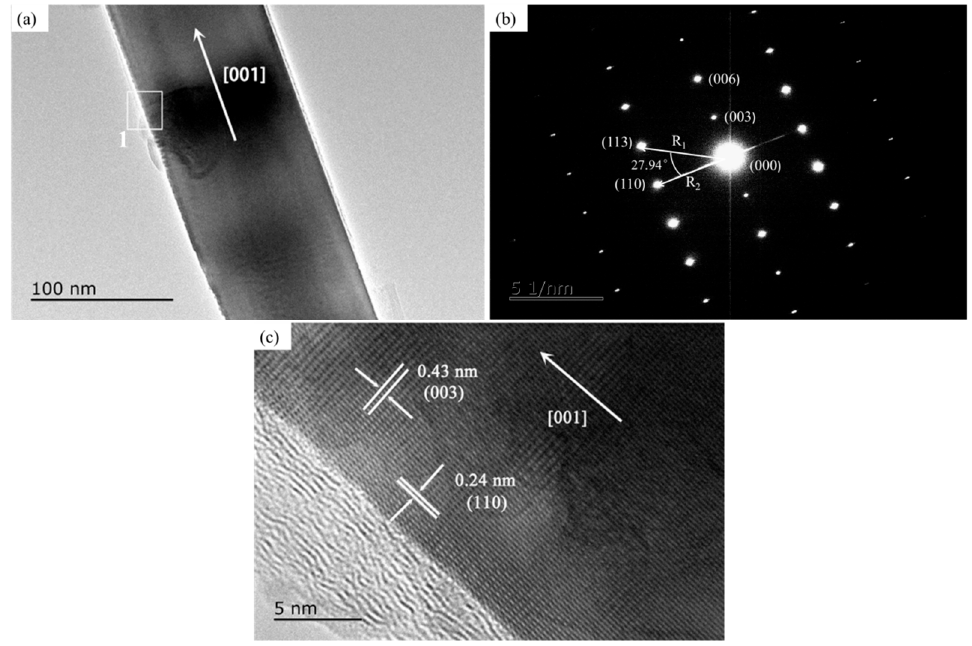
Figure 6. TEM image of Al 2 O 3 whisker: ( a ) general TEM image; ( b ) SAED of Figure 6a; ( c ) high-resolution